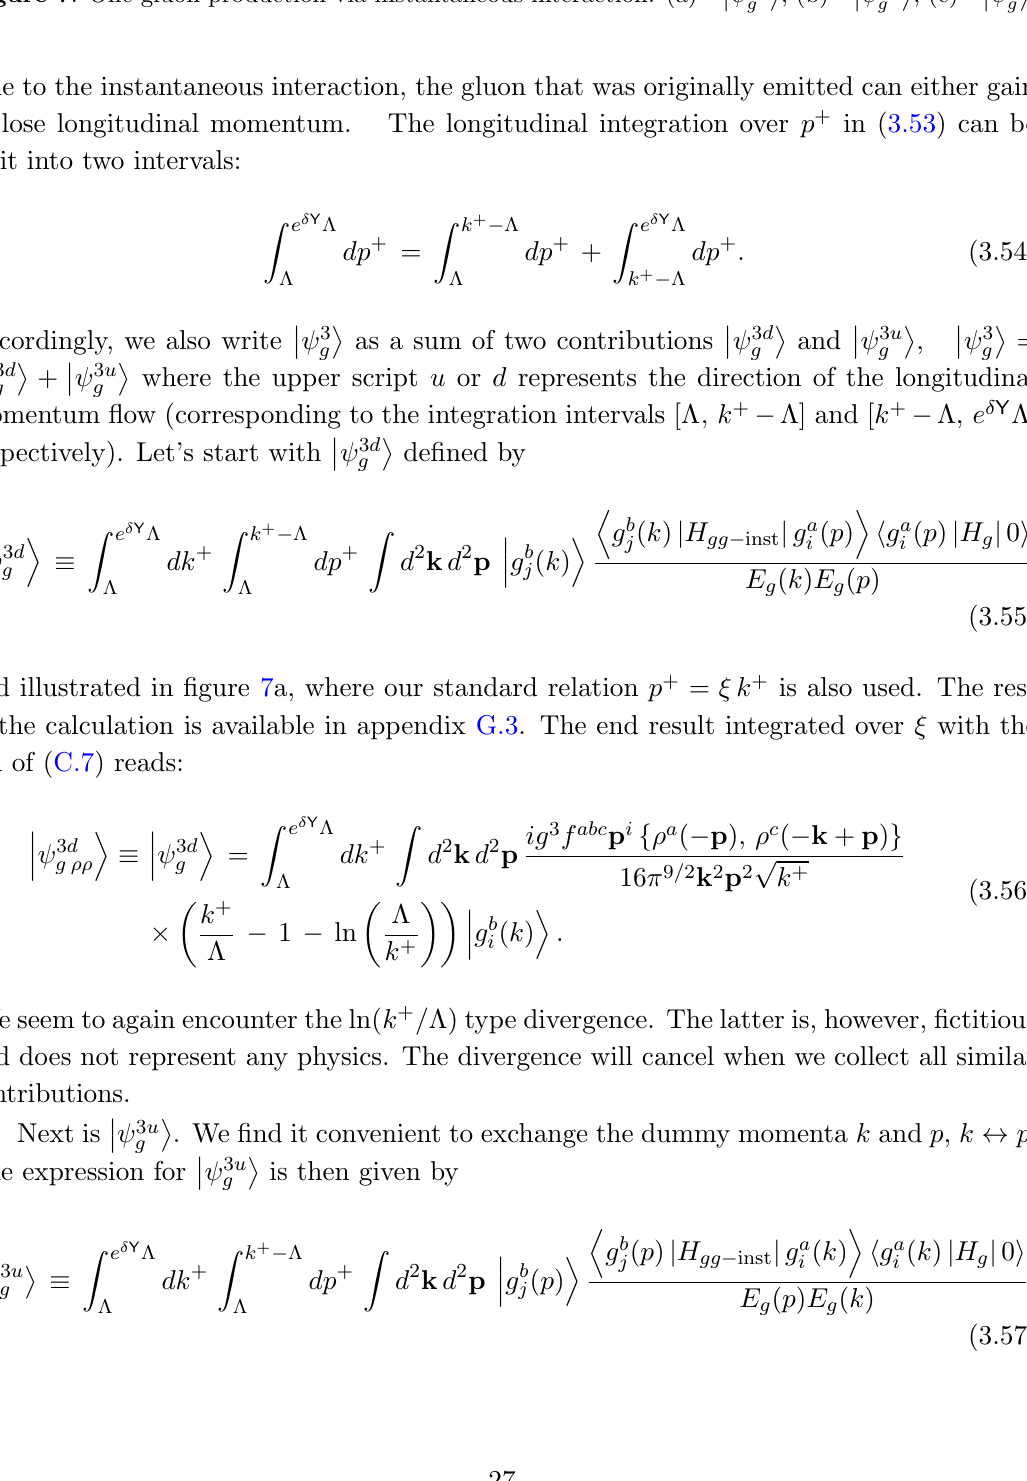
(cid:12) (cid:12) (cid:12) (cid:11) (cid:11) (cid:11) , (b) - , (c) - . (cid:12) 3 d g (cid:12) 3 u g (cid:12) 4 g